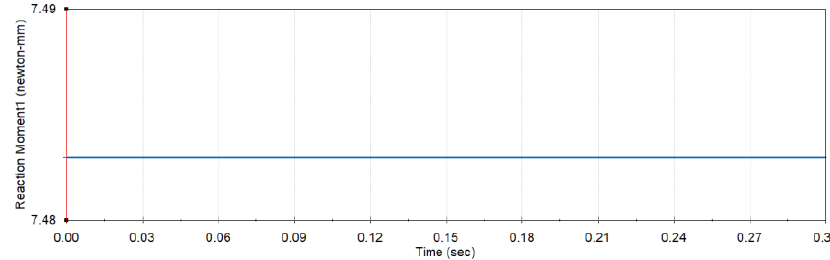
Figure 20. Torque transmitting ratio determined with MBD.